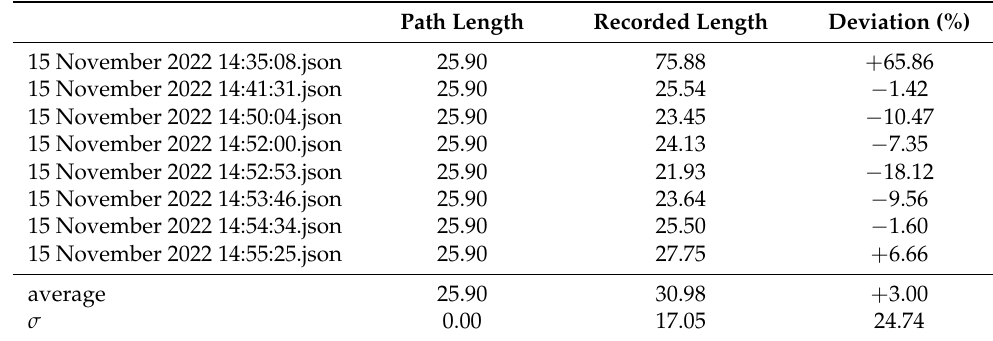
Table 7. Evaluation (Dataset 2): beacon; length-related